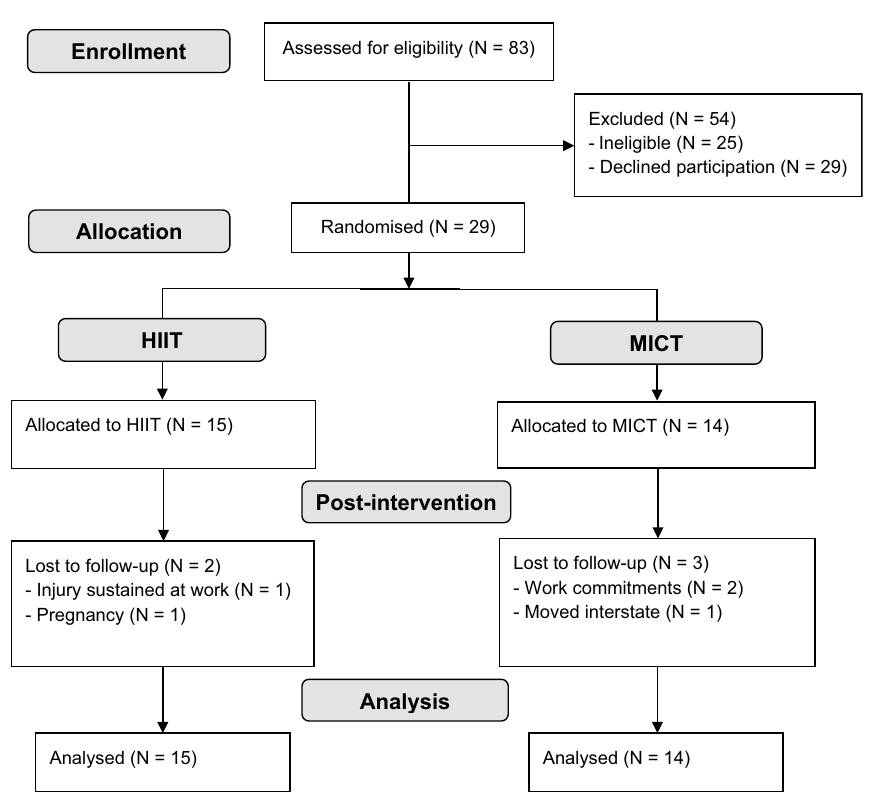
Figure 1. CONSORT trial flow